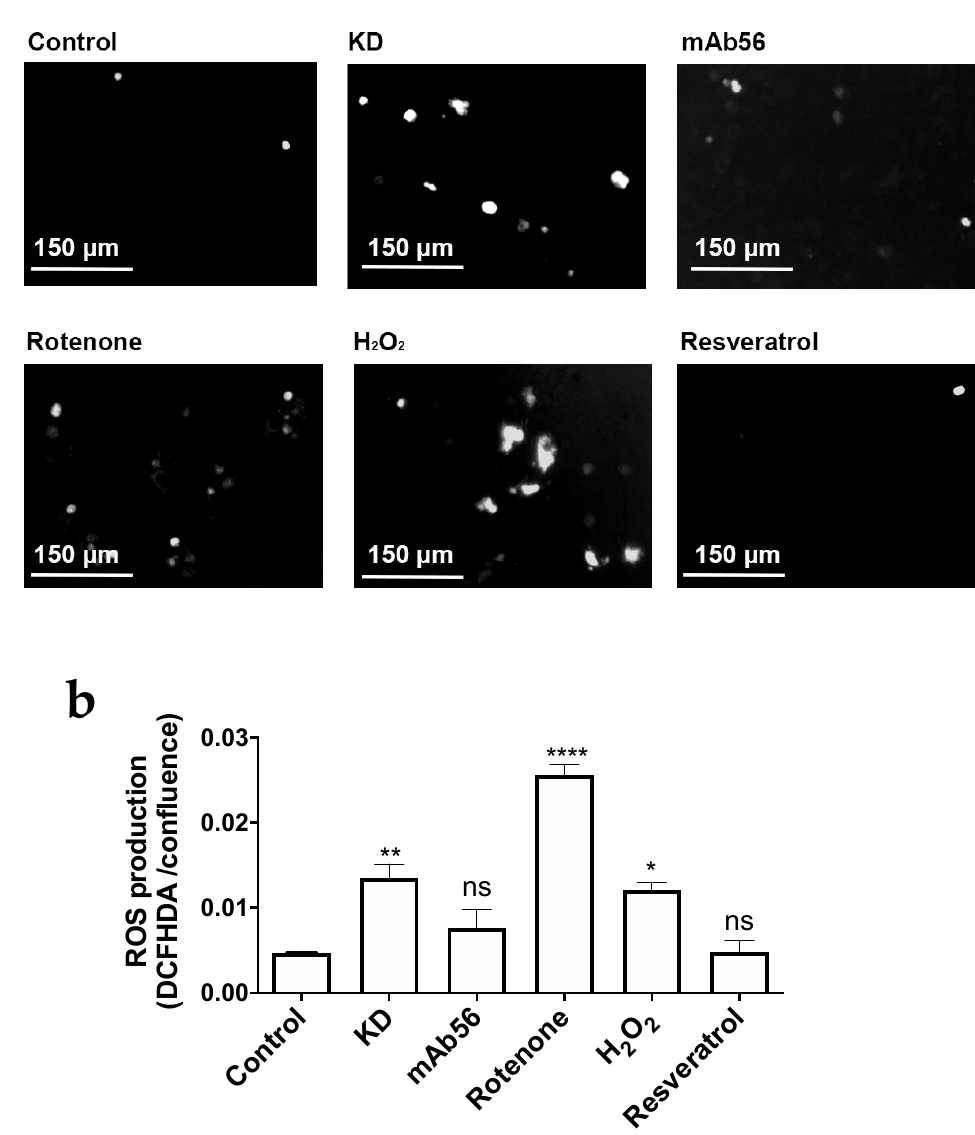
Figure 8. KD cells show n increase in ROS. ( a ) Representative images of the different treatments. HeLa cells were seeded in 96 well plates and stained with DCFHDA. The green fluorescence of DCFHDA was used as a reporter of ROS production using Incucyte device. The different conditions were Kv10.1 knockdown (72 h), mAb56 (10 mg/mL, 12 h), rotenone (10 µM, 12 h), H2O2 (100 µM, 20 min) and resveratrol (30 µM, 24 h). ( b ) Quantification of ROS production (expressed as integrated fluorescence intensity normalized for cell confluence in phase contrast). Mean ± SEM of three independent experiments; * p < 0.05; ** p < 0.01; **** p < 0.0001, ANOVA. To determine whether a decrease of surface expression or the requirement of a functional Kv10.1 is responsible for this observation, non-silenced cells were incubated for 12 h with 10 µg/mL of the blocking antibody mAb56. The use of mAb56 in control cells also produced a modest increase in the DCFHDA signal, which was not significant when normalized for cell confluence.